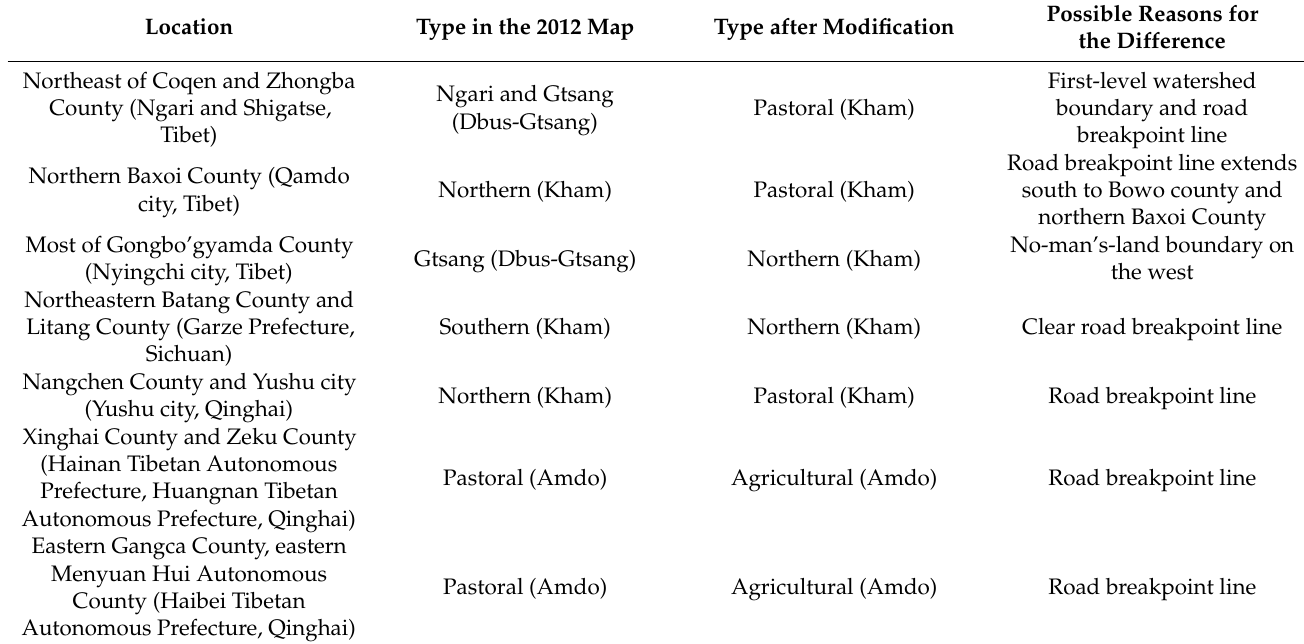
grade road breakpoint lines, whose stability is lower than that of the physical elements. Table 2. Seven boundary segments of (sub)dialect areas with significant differences and reasons.